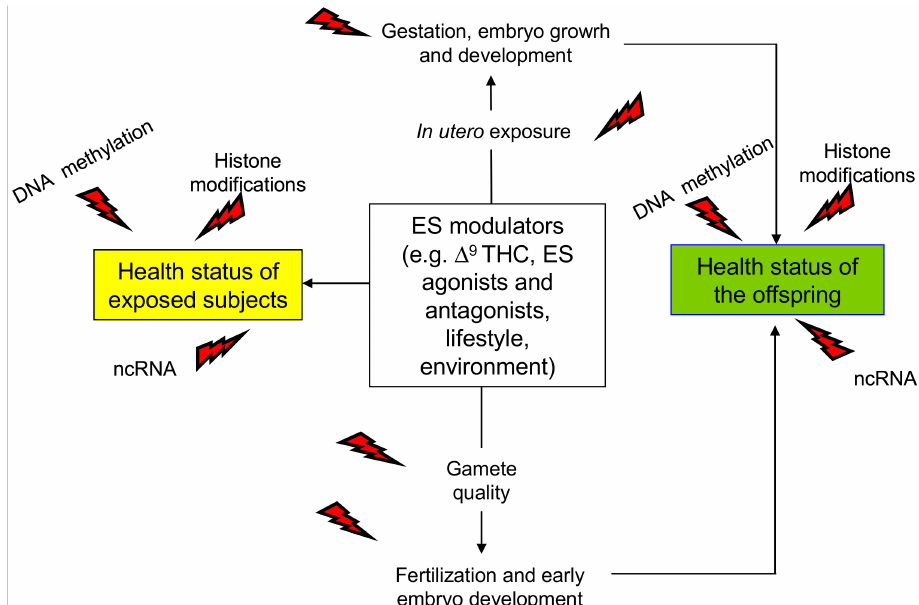
Figure 1. Schematic representation of the main outcomes of endocannabinoid system (ES) epigenetic modulation. Directe ff ectsareinyellowbox; trans-generationale ff ectsoccurringviagametesorfollowing in utero exposure are in green box. ncRNA: non-coding RNA; ∆ 9 THC: ∆ 9 -tetrahydrocannabinol, red flash of lightning indicates the epigenetic